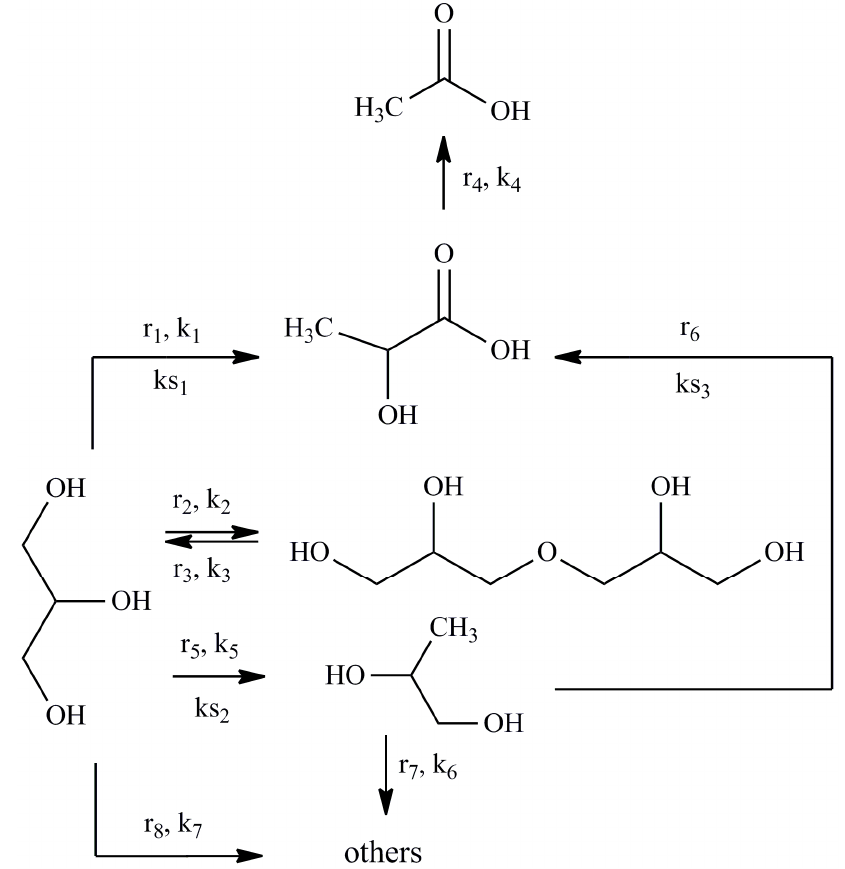
Figure 2. A simplified scheme of glycerol conversion reaction